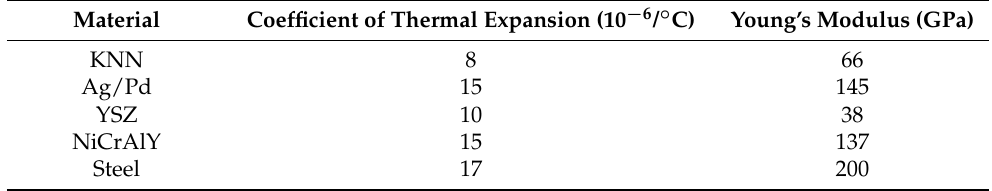
Table 2. Thermal expansion coefficient comparison table [15–17].